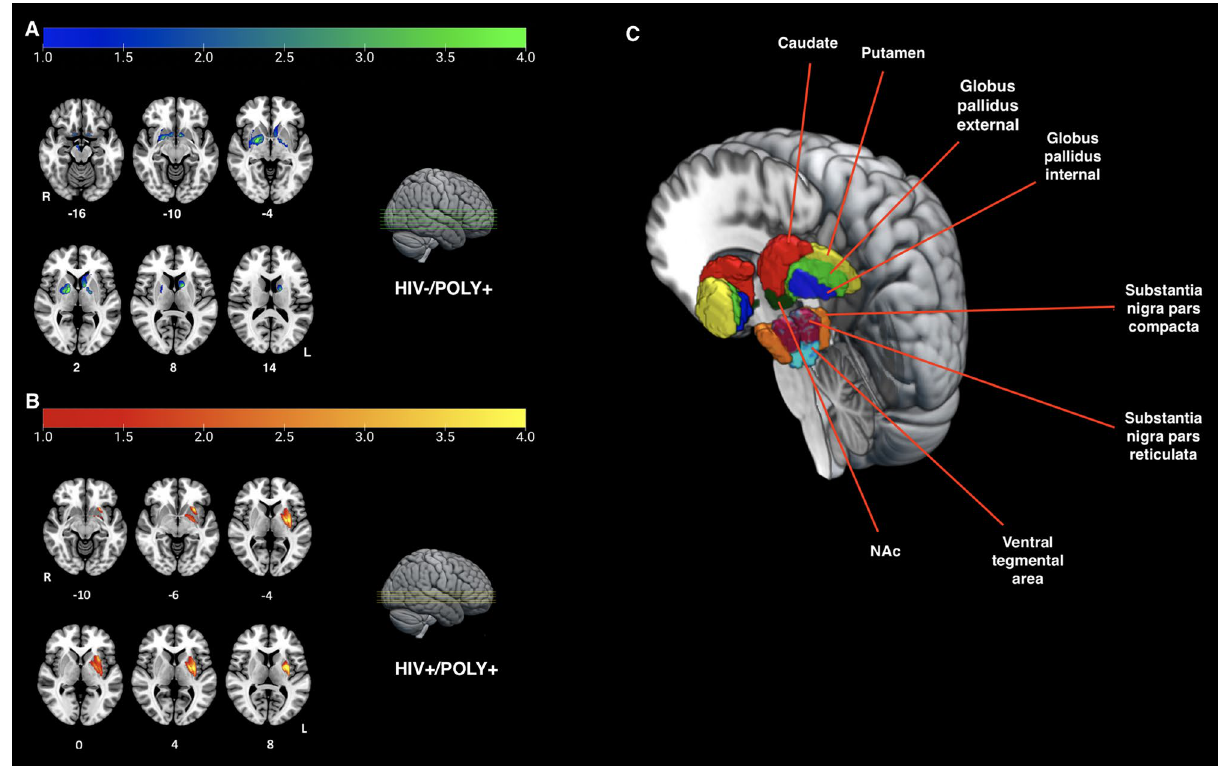
Figure 3. POLY + group regressions of basal ganglia gray matter volume and substance use duration. ( A ) Statistical map of z-scores indicating reduced gray matter (GM) as a function of opioid use duration in the HIV-/POLY + group; z-planes = -16, -10, -4, 2, 8, 14 in MNI space ; p < 0.05 FWE. R = right hemisphere, L = left hemisphere; ( B ) Statistical map of z-scores indicating increased GM as a function of stimulant use duration in the HIV + /POLY + group; z-planes = -10, -6, -4, 0, 4, 8 in MNI space ; p < 0.05 FWE. R = right hemisphere, L = left hemisphere. ( C ) Depiction of basal ganglia ROI masks that were used for regression analyses with substance use duration, shown here overlaid on the SPM152 template for